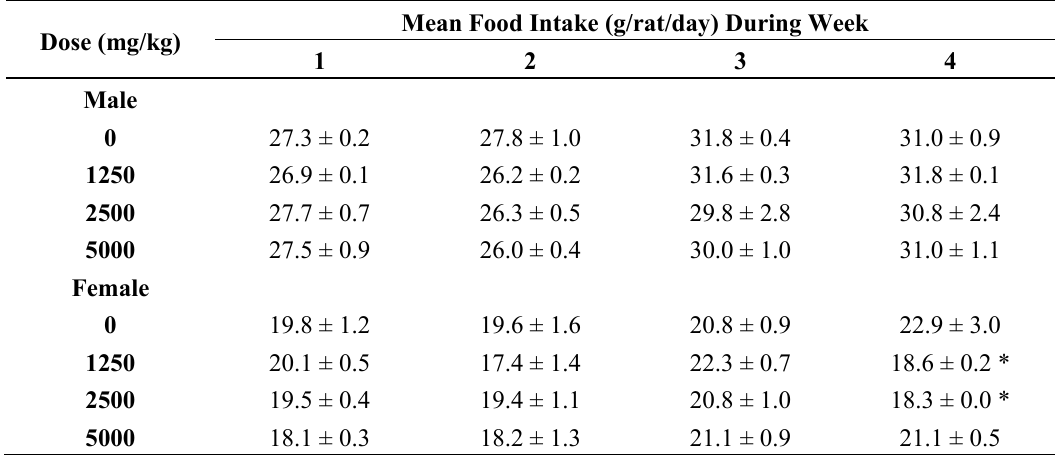
Table 2. Mean food consumption of male and female rats treated with C. setidens for 4 weeks. Dose (mg/kg)